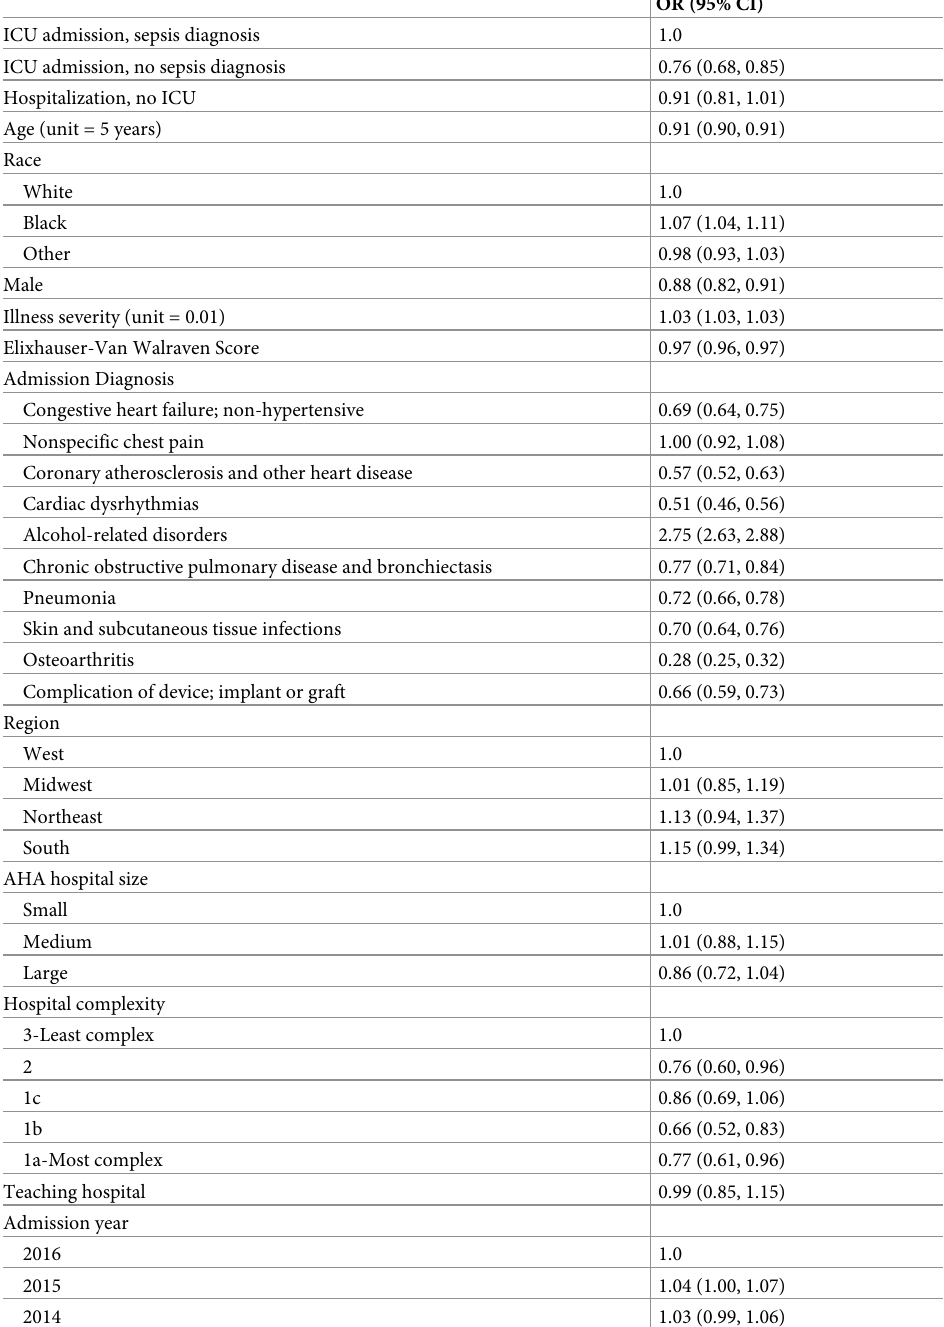
Table 4. New antipsychotic use in the year following